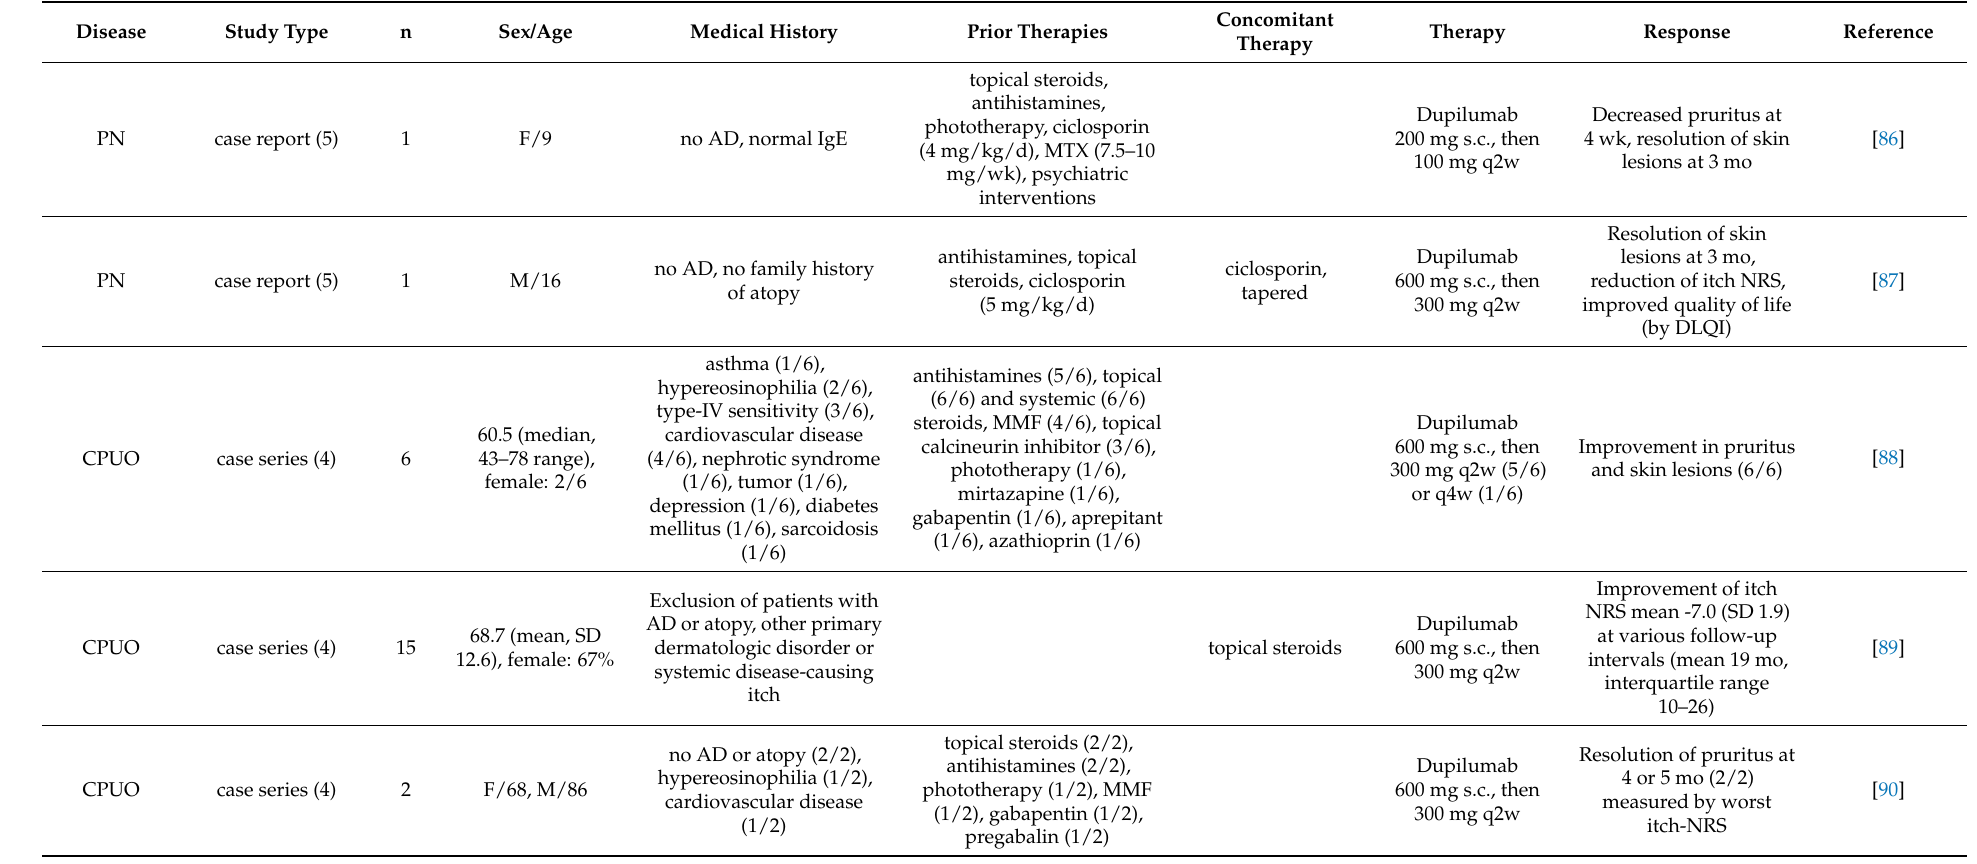
Table 2. Chronic pruritus and